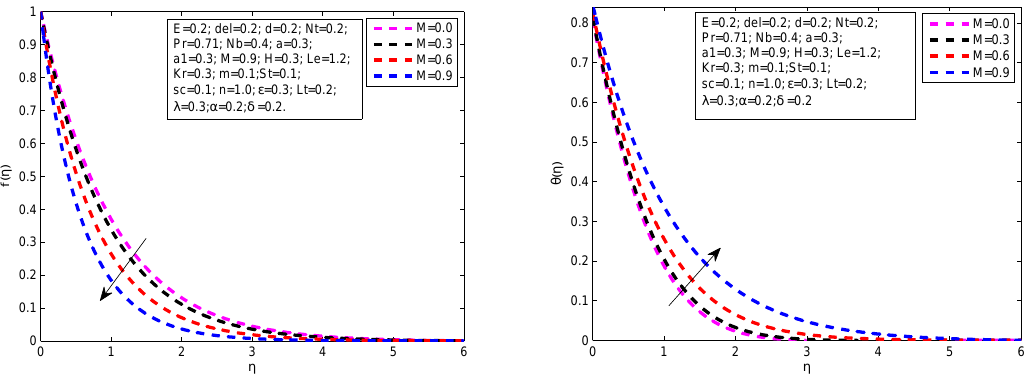
Figure 3. The f (cid:48) and θ for distinct values of St .